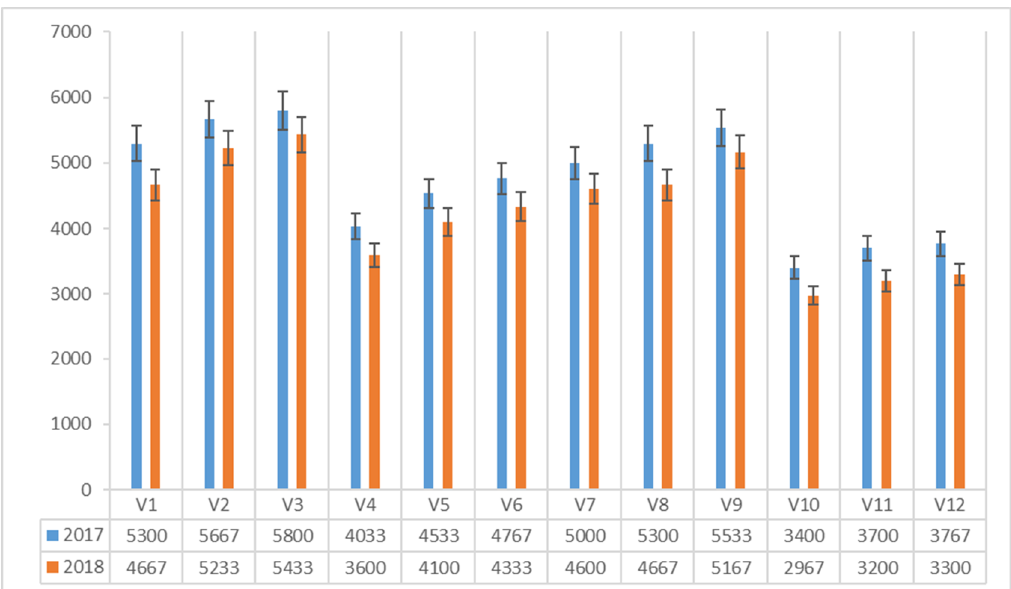
Figure 3. Vitamin B 1 content of Agaricus blazei Murrill mushrooms (μg 100g −1 dm) in two years of experiments.